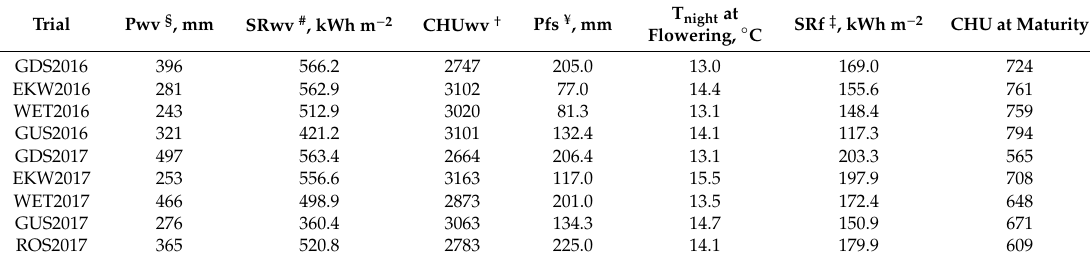
Table 3. Overview of weather conditions at the trial